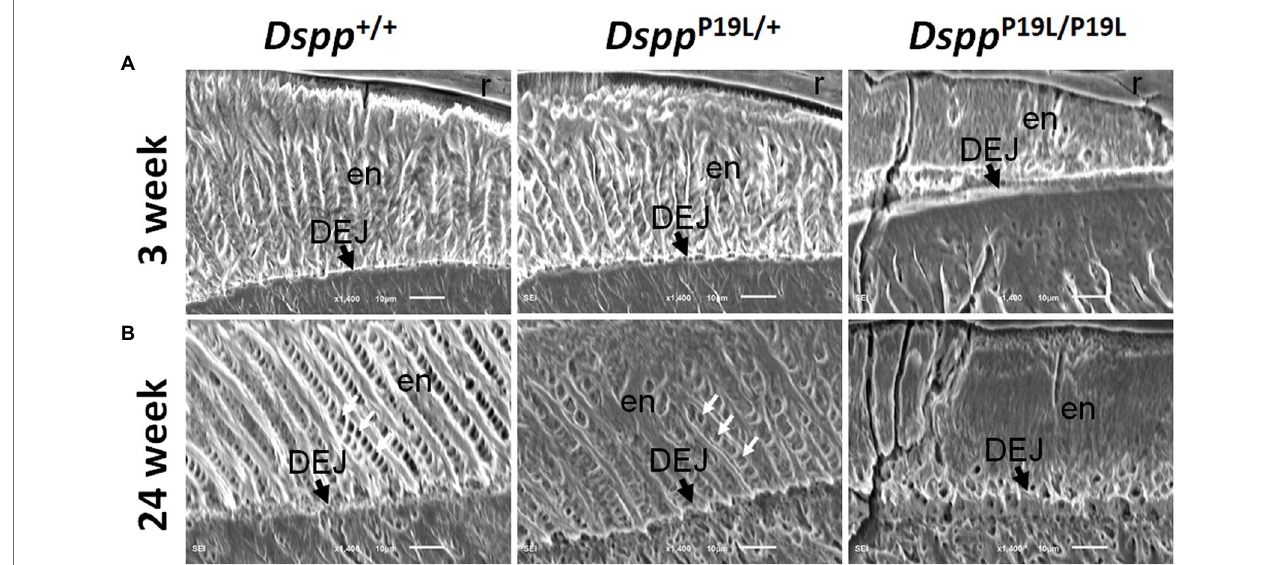
FIGURE 5 | Acid-etched SEM analyses of the mandibular first molars. Shown are the acid-etched SEM images of the mandibular first molars of 3- (A) and 24- (B) week-old wild-type Dspp +/+ , heterozygous Dspp P19L/+ and homozygous Dspp P19L/P19L mice. All images are the longitudinal sections and buccal sides of the mandibular first molars. At the age of 3 weeks, Dspp P19L/+ mice showed a similar acid-etching pattern in enamel (en) as the wild-type mice. At the age of 24 weeks, Dspp +/+ mice presented an acid-etching pattern, with the cross-sectioned enamel rods (pointed by white arrows) preferentially removed by acid; although Dspp P19L/+ mice displayed a similar pattern, the cross-sectioned enamel rods (pointed by white arrows) were not as well-defined as the wild-type mice. There were no recognizable enamel rods in Dspp P19L/P19L mice at both ages. The dentinoenamel junction (DEJ) appeared to be different in Dspp P19L/P19L mice, compared to age- matched Dspp +/+ and Dspp P19L/+ mice. en, enamel; DEJ, dentinoenamel junction; and r, resin. Scale bars: 10 μ